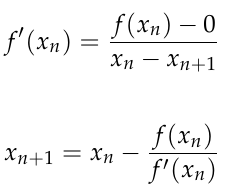
Figure 5. Flow chart of the overall simulation procedure to calculate Seiliger parameters.